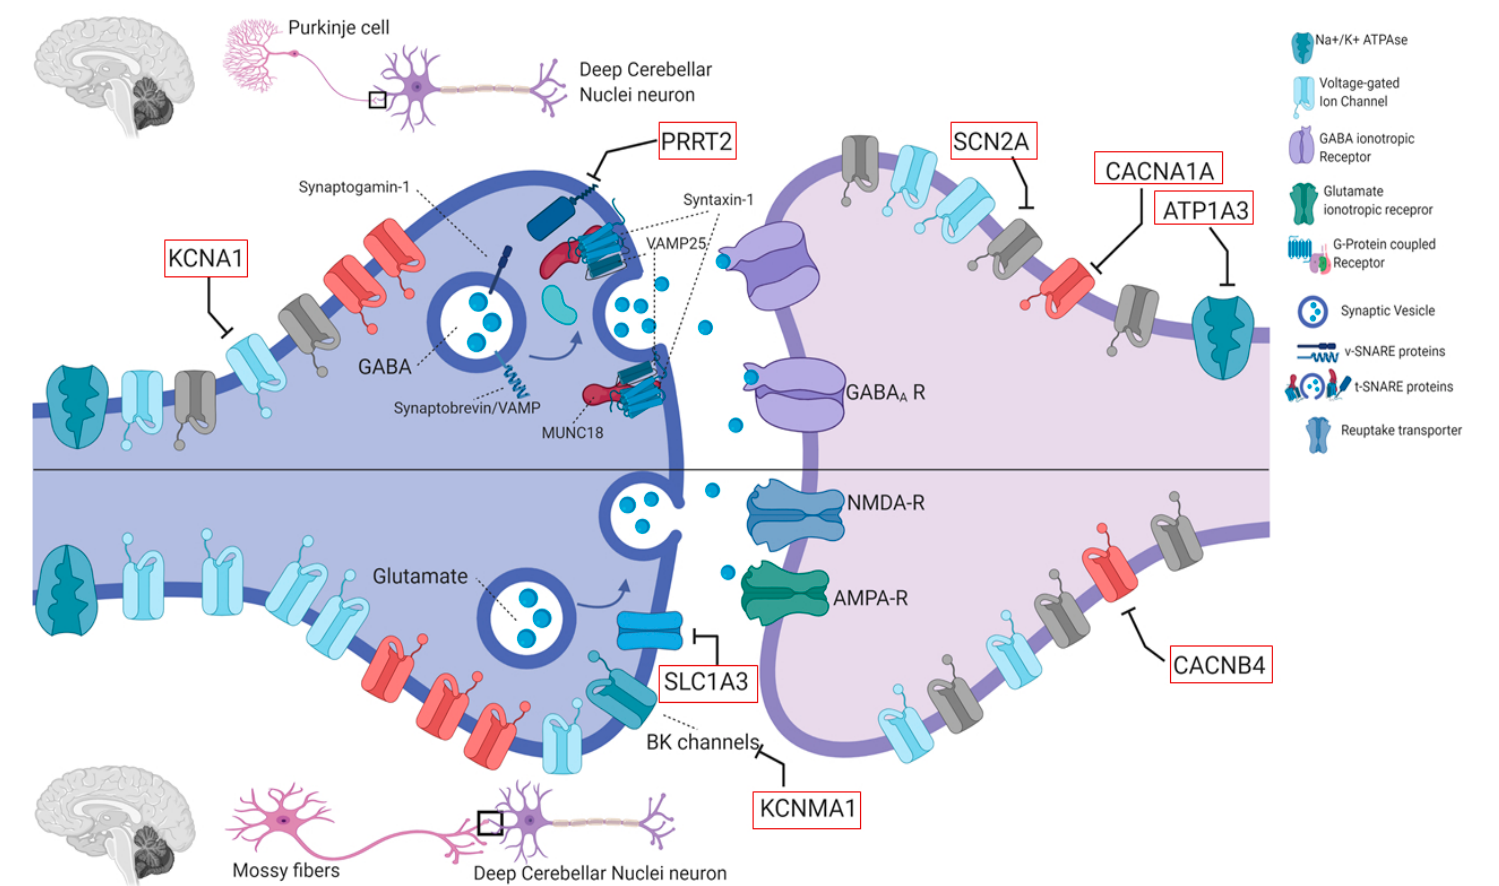
Figure 3. Schematic representation of synaptic neurotransmission mechanisms a ff ected in PMDs in cerebellar circuits. For simplicity, two hypothetical synapses are shown: The GABAergic synapse between a Purkinje cell and a neuron of deep cerebellar nuclei ( top ), and the synapse between a glutamatergic cerebellar a ff erent (mossy fiber) and a neuron of deep cerebellar nuclei ( bottom ). Both these types of synapses are critical for cerebellar integration and coordination of movements. Red rectangles indicate genes involved in PMDs. Calcium channels are depicted in red, sodium channels in grey, potassium channels in blue.